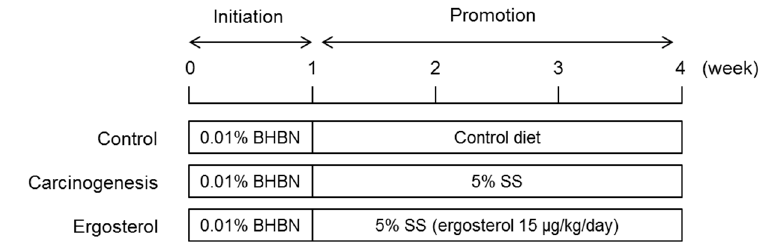
Figure 1. Experimental design.